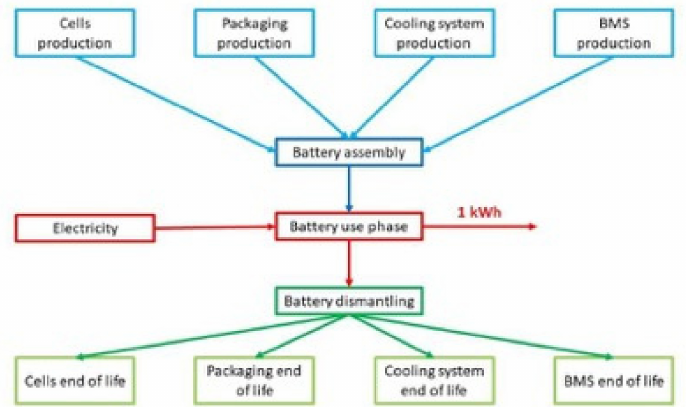
Figure 2. Schematic representation of the analyzed system. The functional unit is 1 kWh of energy delivered by the battery. BMS: battery management system.